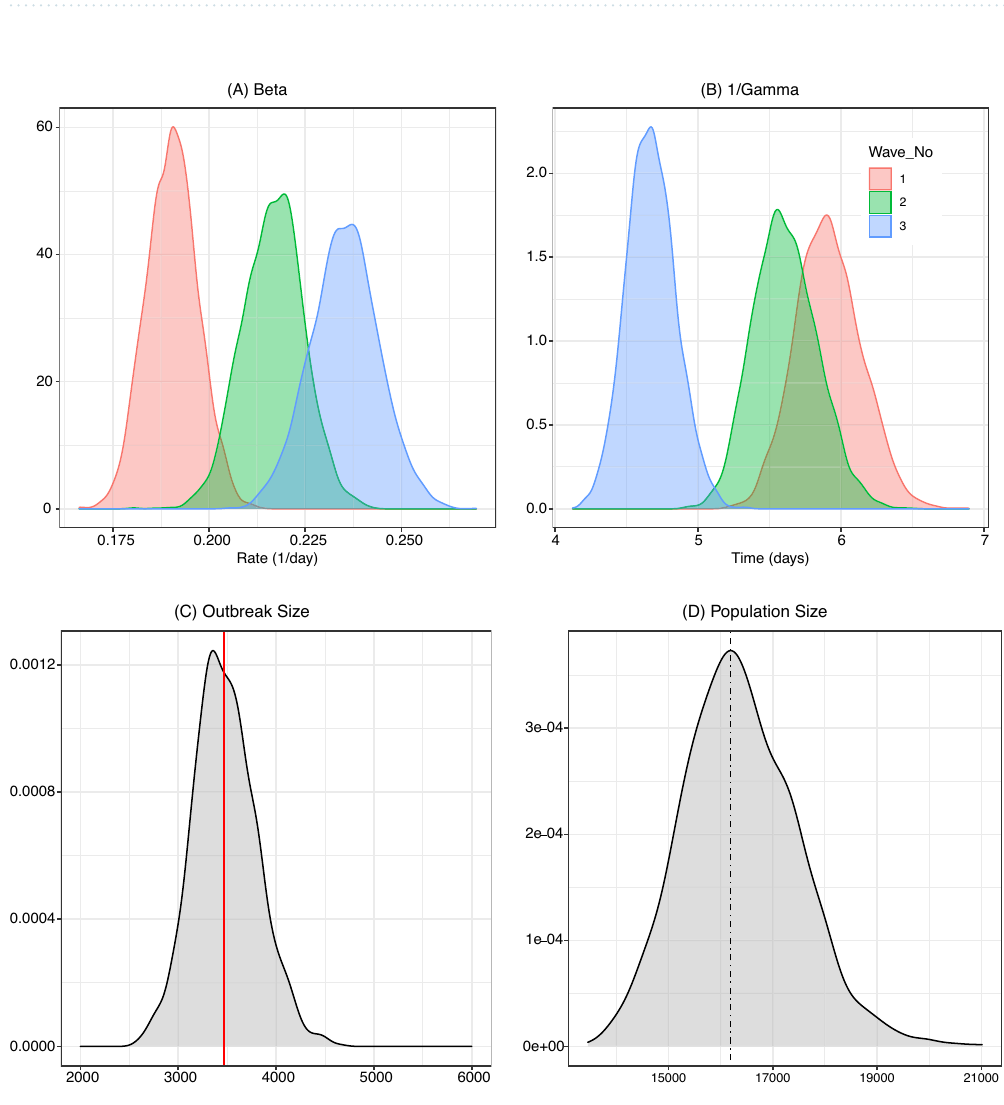
Figure 4. Top panels: parameters in different waves. The posterior distributions of β and 1 /γ parameters for each of the three epidemic waves. The large increase in the rate of infection between waves 1 and 2 is clearly visible in panel ( A ). In panel ( B ), the density of 1 /γ represents the distribution of time from symptom onset to removal. Between wave 1 and wave 3 of the epidemic, the average time shortened from 6 to 4.6 days. Bottom panels: outbreak size and effective population size. ( C ) The posterior density of the outbreak size based on the statistical model and the actual number of observed EVD cases (vertical red line). ( D ) The posterior density of the effective population size for the epidemic. The vertical line corresponds to the empirical outbreak size (red line in panel ( C